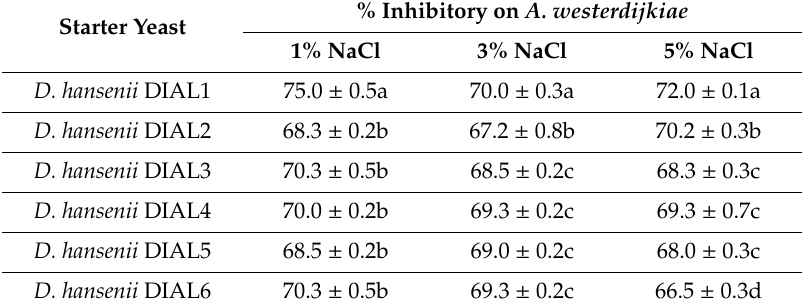
Table 2. Percentage of inhibitory activity of Debaryomyces hansenii vs A. westerdijkiae co-inoculated in agar plates.